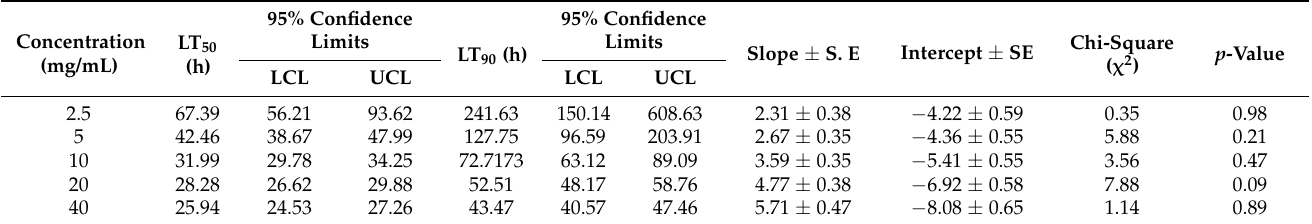
Table 3. Lethal time causing 50% and 90% mortalities (LT 50 and LT 90 values) at varying concentrations for D. innoxia against R. microplus in